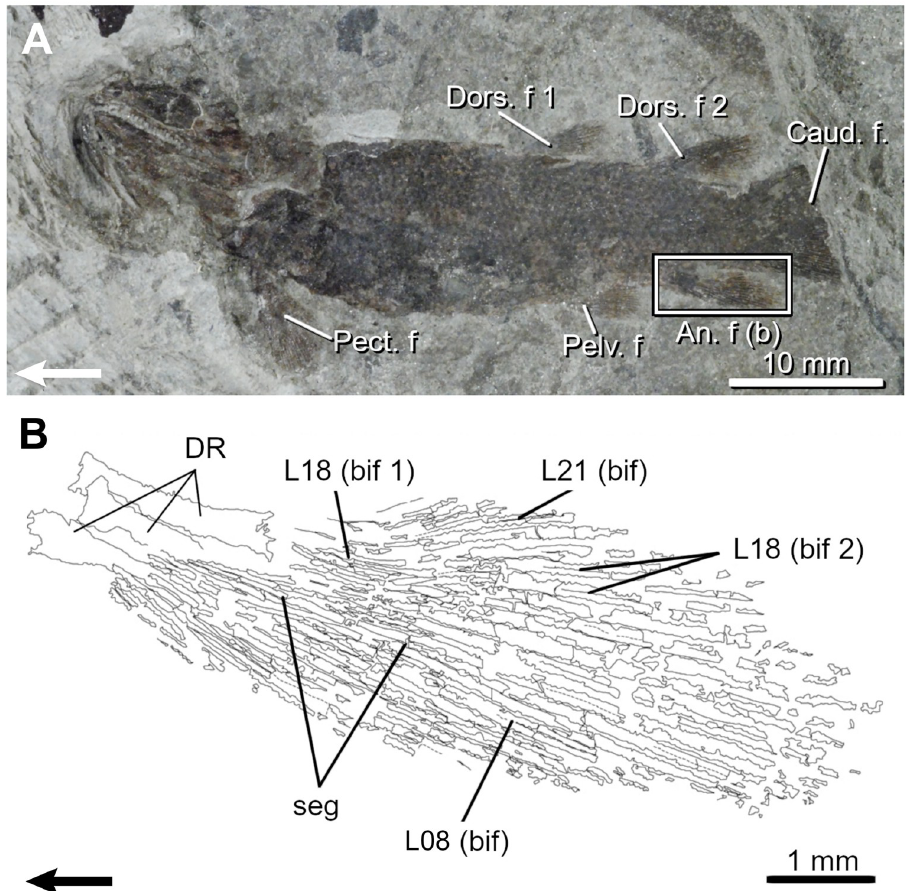
Fig 10. The Devonian ‘osteolepiform’ Eusthenopteron foordi . A, Very small fossil specimen (MHNM 06–1754) and a drawing of its anal fin (B). Arrows point anteriorly. An. f, anal fin; bif, bifurcation; Caud. f, caudal fin; Dors. f, dorsal fin; DR, distal radial; L, lepidotrichia; Pect. f, pectoral fin; Pelv. f, pelvic fin; seg, segmentation.